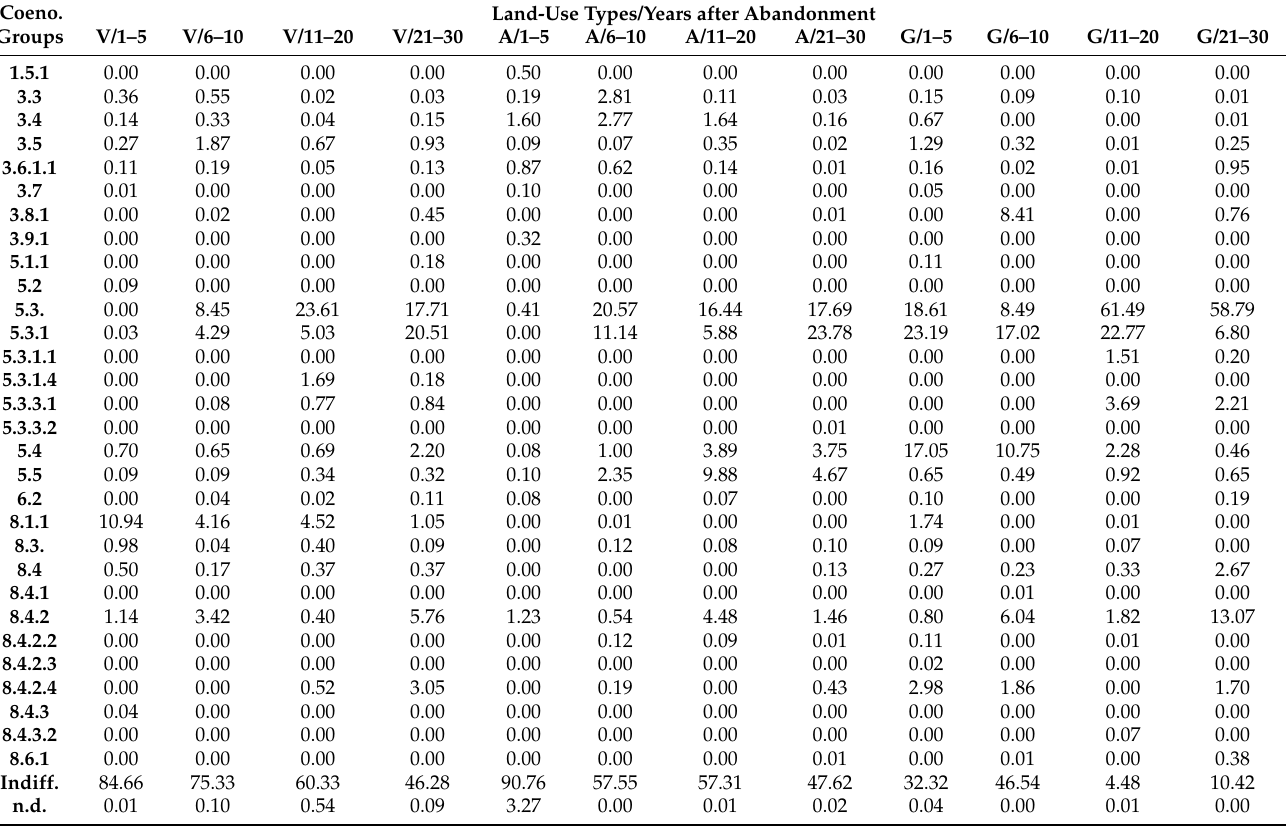
Table 3. Relative average cover of coenosystamatical groups of the species of abandoned